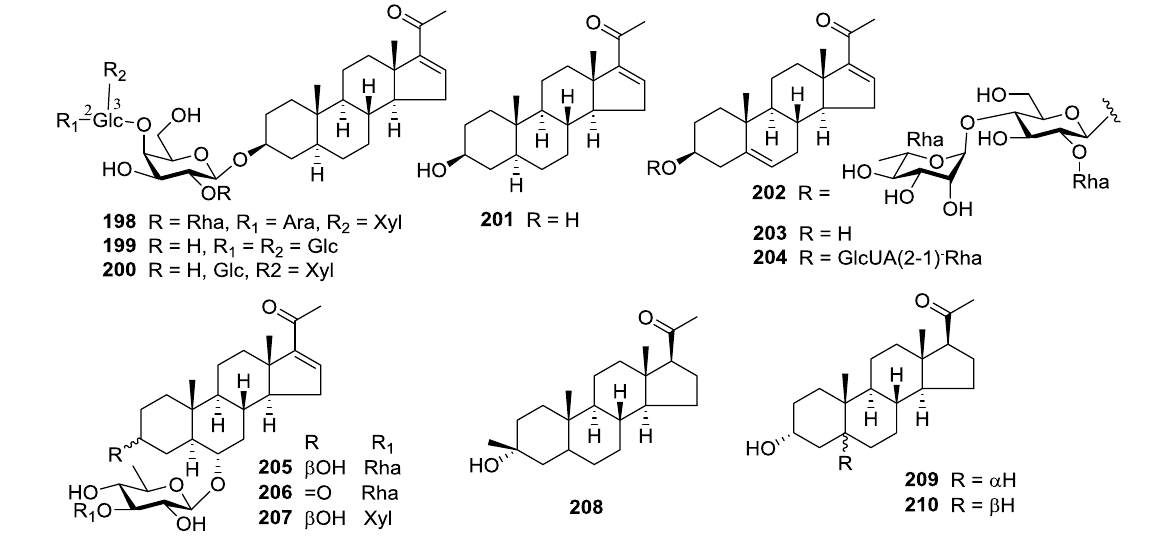
Fig. 3 Pregnane glycosides 198 – 210 from